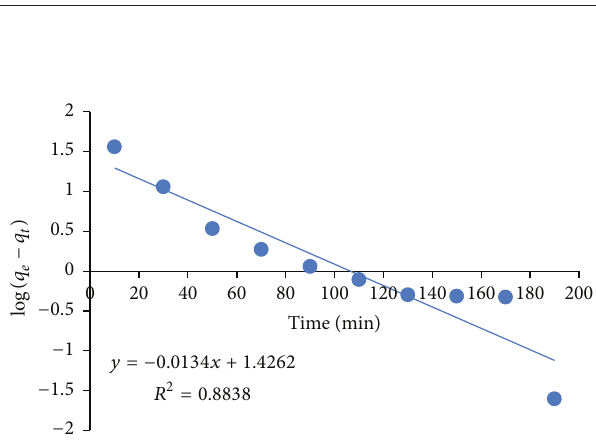
Figure 6: Kinetic study of adsorption of RO16 on MKCF by using pseudo-first-order kinetic model ( 𝐶 𝑜 = 100